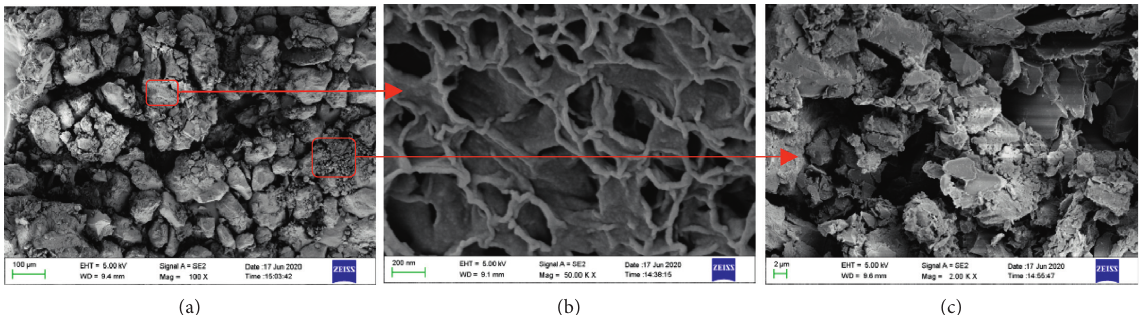
Figure 13: Microstructure of saline soils stabilised with NaOH and GGBS. (a) Close-up of specimen; (b) and (c) hydration products.